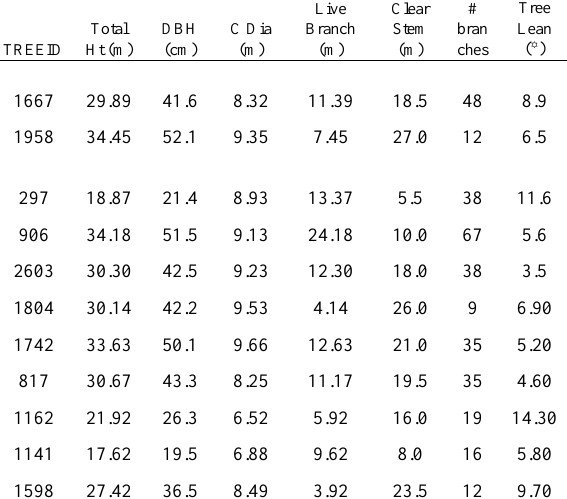
Table 2. Estimated characteristics of a few sampled trees